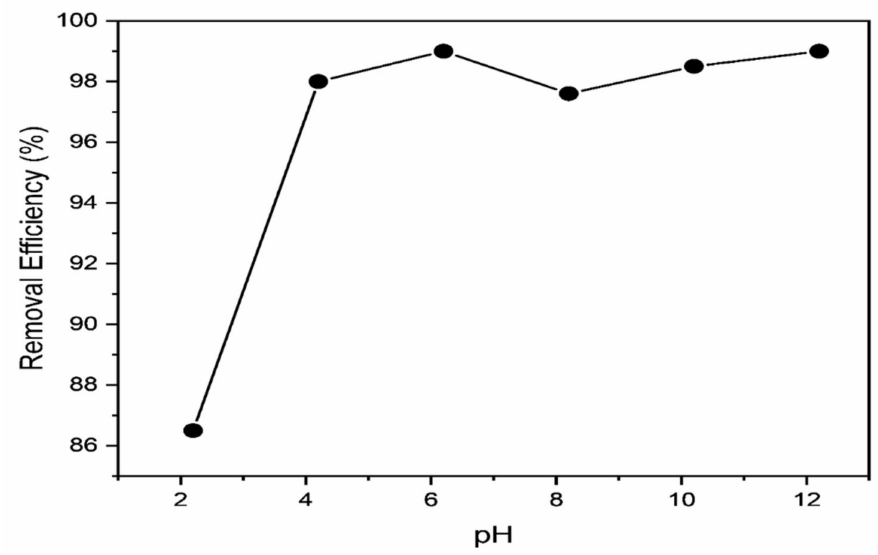
Figure 10. Impact of pH on MB